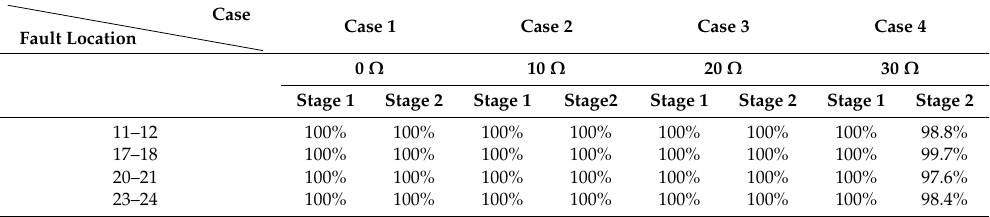
Table 10. Accuracy of fault location according to the measurement noises (faults in lateral feeder).